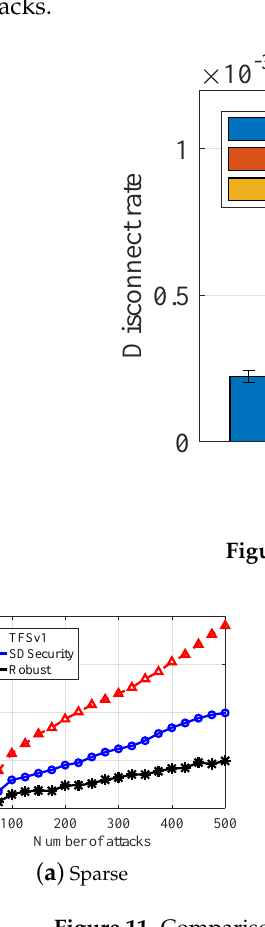
Figure 11. Comparison under MITM attack. ( a ) sparse; ( b ) moderate; ( c )